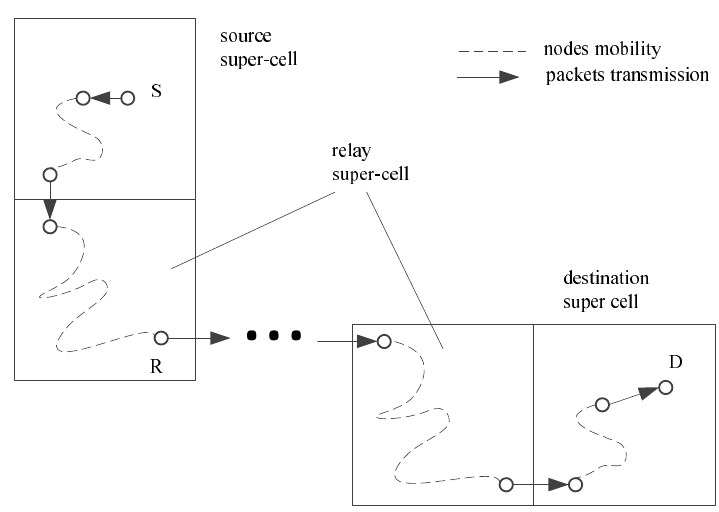
Figure 2. Multi-hop relay and slots allocation